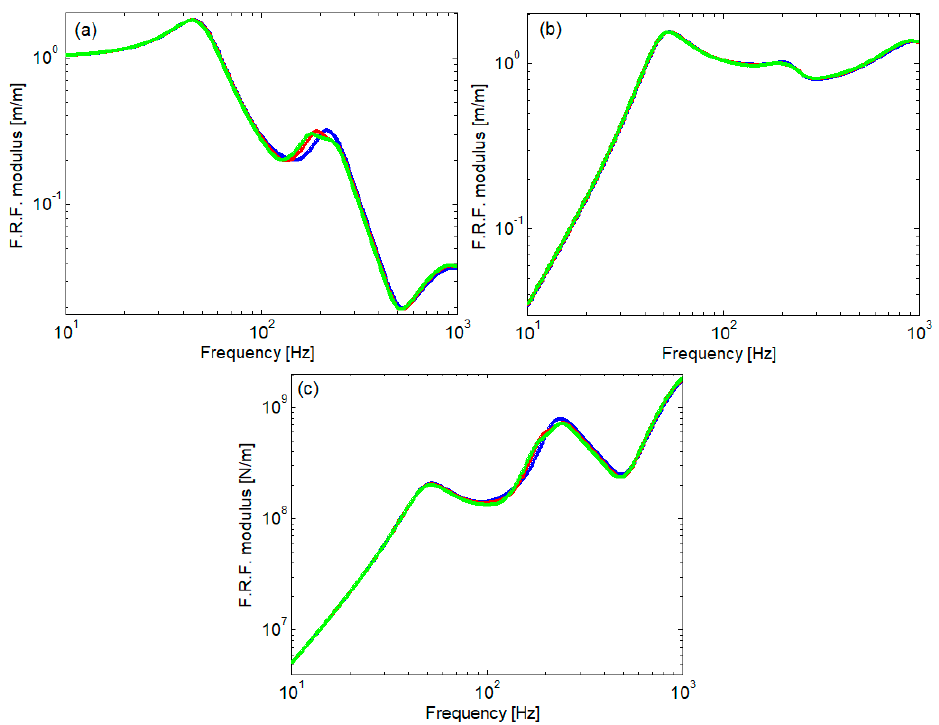
Figure 16. Frequency Response Function modulus: ( a ) wheel displacement; ( b ) rail displacement; ( c ) contact force; color code as in Figure 15.